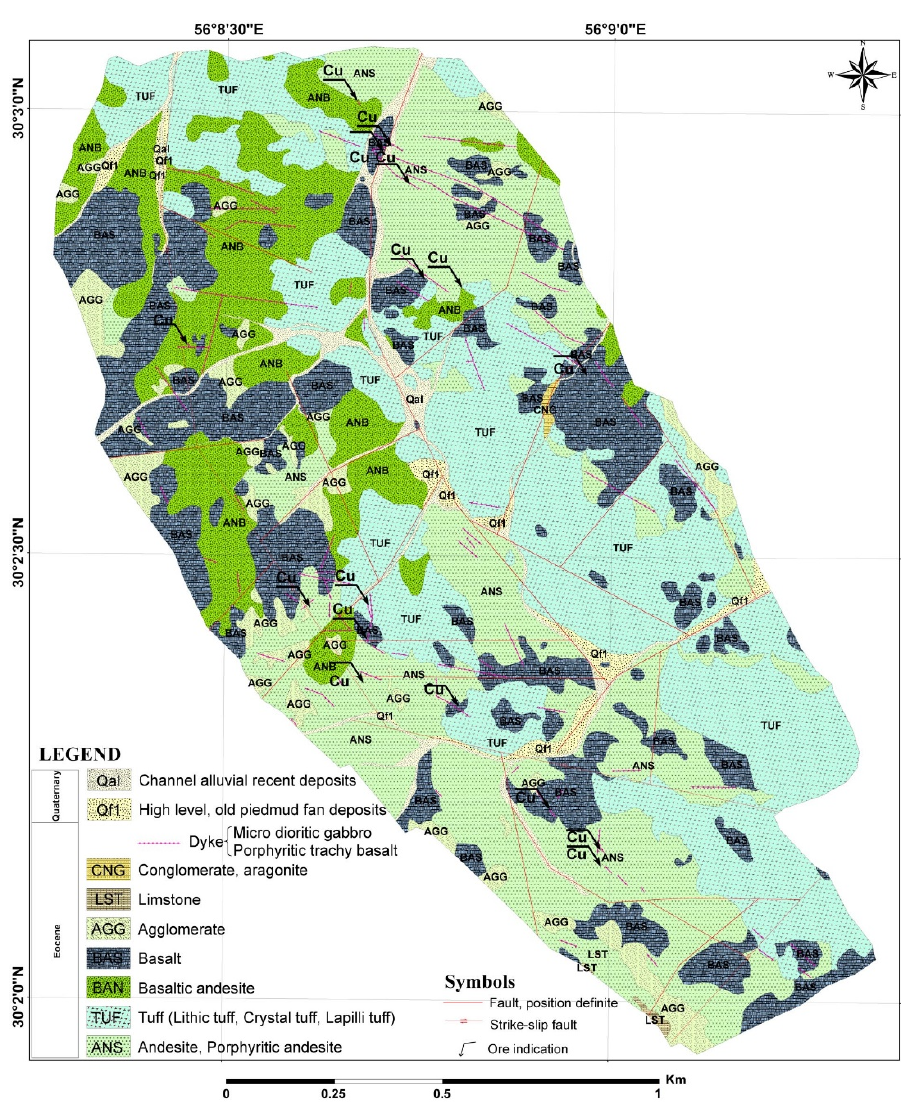
Figure 9. Geology map of the Shahzadeh Abbas deposit.